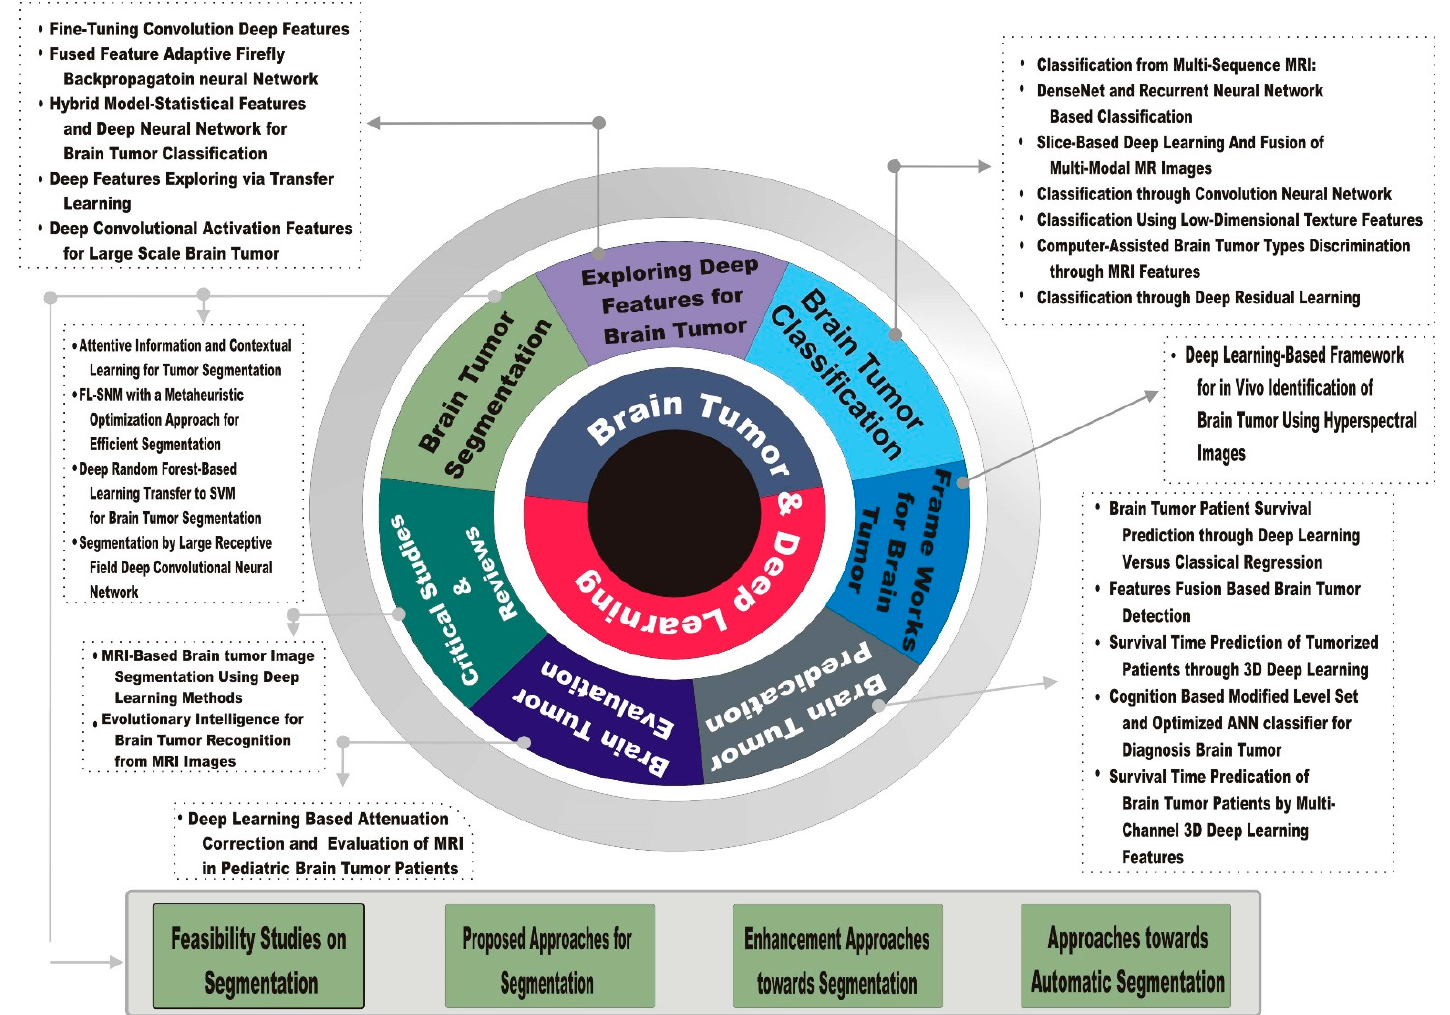
Figure 2. Literature Taxonomy of brain tumor using deep learning . 105